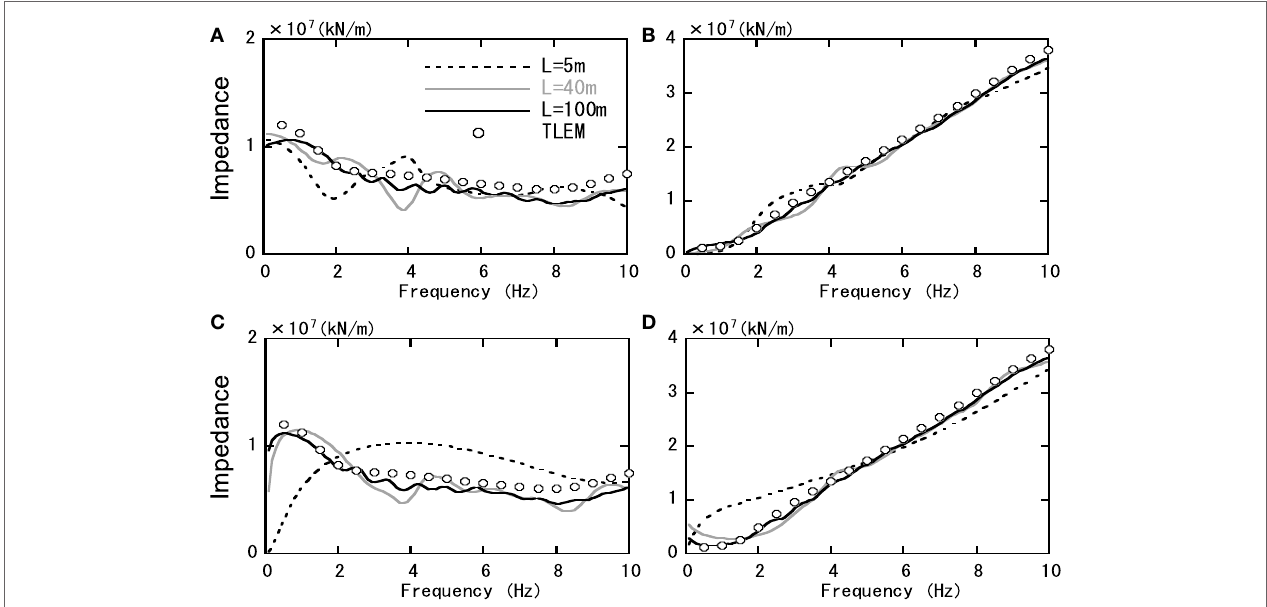
FigUre 9 | comparison of soil impedance (horizontal) . (a) 3D-TB (real). (B) 3D-TB (imag.). (c) VB (real). (D) VB